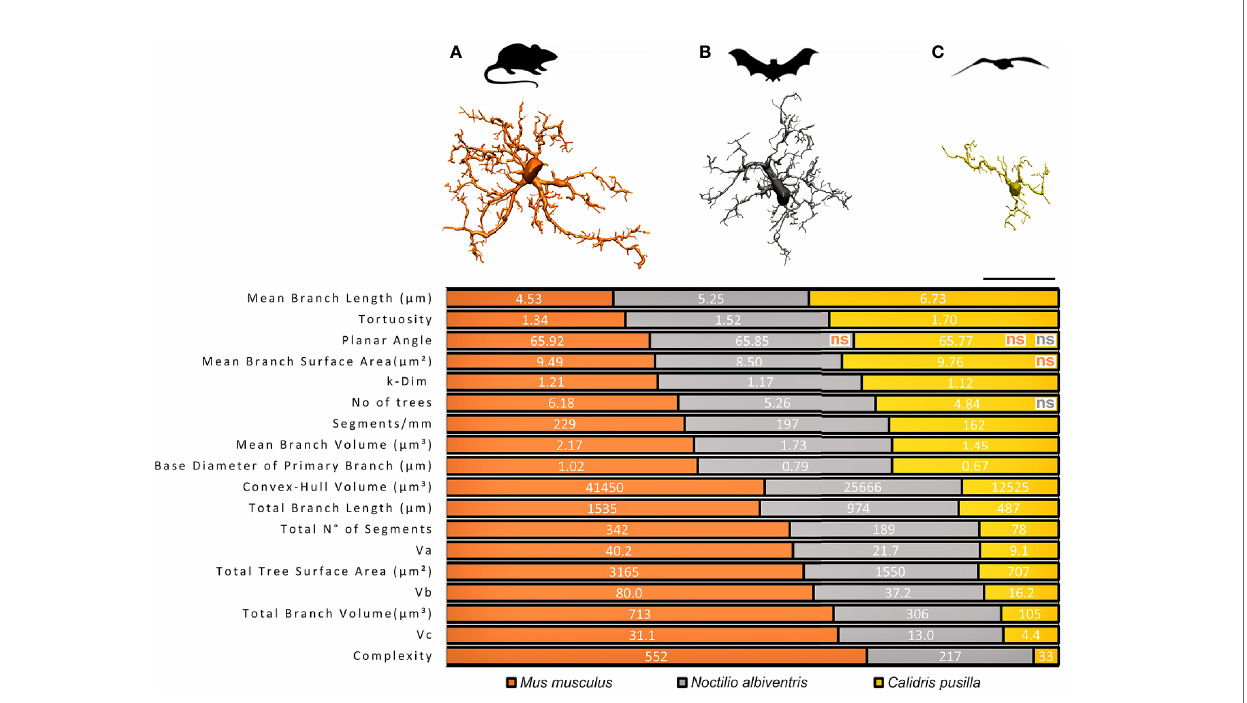
FIGURE 1 | Graphical representation of the comparative analysis of morphometric features between species. Top, schematic illustration of M. musculus (A) , N. albiventris (B) C. pusilla (C) with correspondent three-dimensional reconstructions of microglia performed in the dentate gyrus of mammals and in the hippocampal V region of C. pusilla . 3D representative reconstructions of microglia are closest to the “ mean cell ” of each species. All morphometric features comparisons between species are signi fi cantly different (p < 0.05), except those indicated as non-signi fi cant (ns), and reproducing the color of the species being compared with C. pusilla . Three distinct mean values of each morphometric variable, one for each species, are exhibited on each line over three distinct colored areas as follows: orange, gray and yellow shaded areas corresponding to M. musculus , N. albiventris and C. pusilla , respectively. Note that the extent of each color shaded area on each line are the mean percentual values of each species. Scale bar = 25